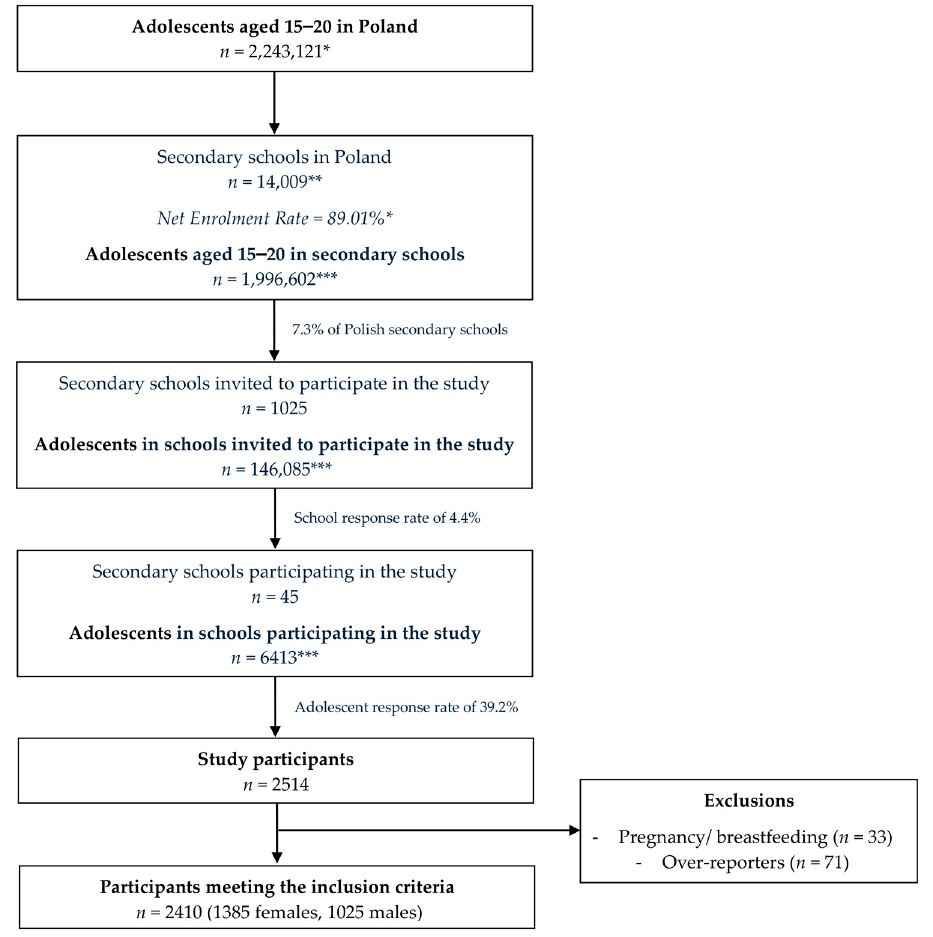
Figure 1. The detailed sampling procedure and recruitment of the studied group. * Central Statistical O ffi ce (CSO) data [20,22], ** Polish Ministry of National Education data [23], *** calculated based on Central Statistical Office (CSO) data [22].